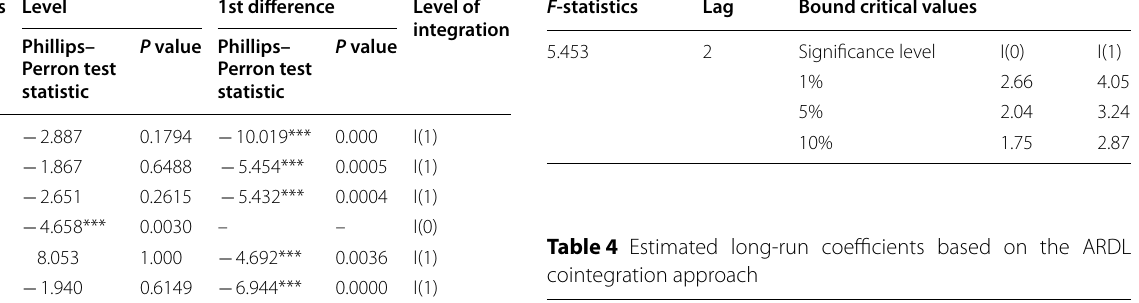
Table 2 Phillips–Perron unit root test Variables Level